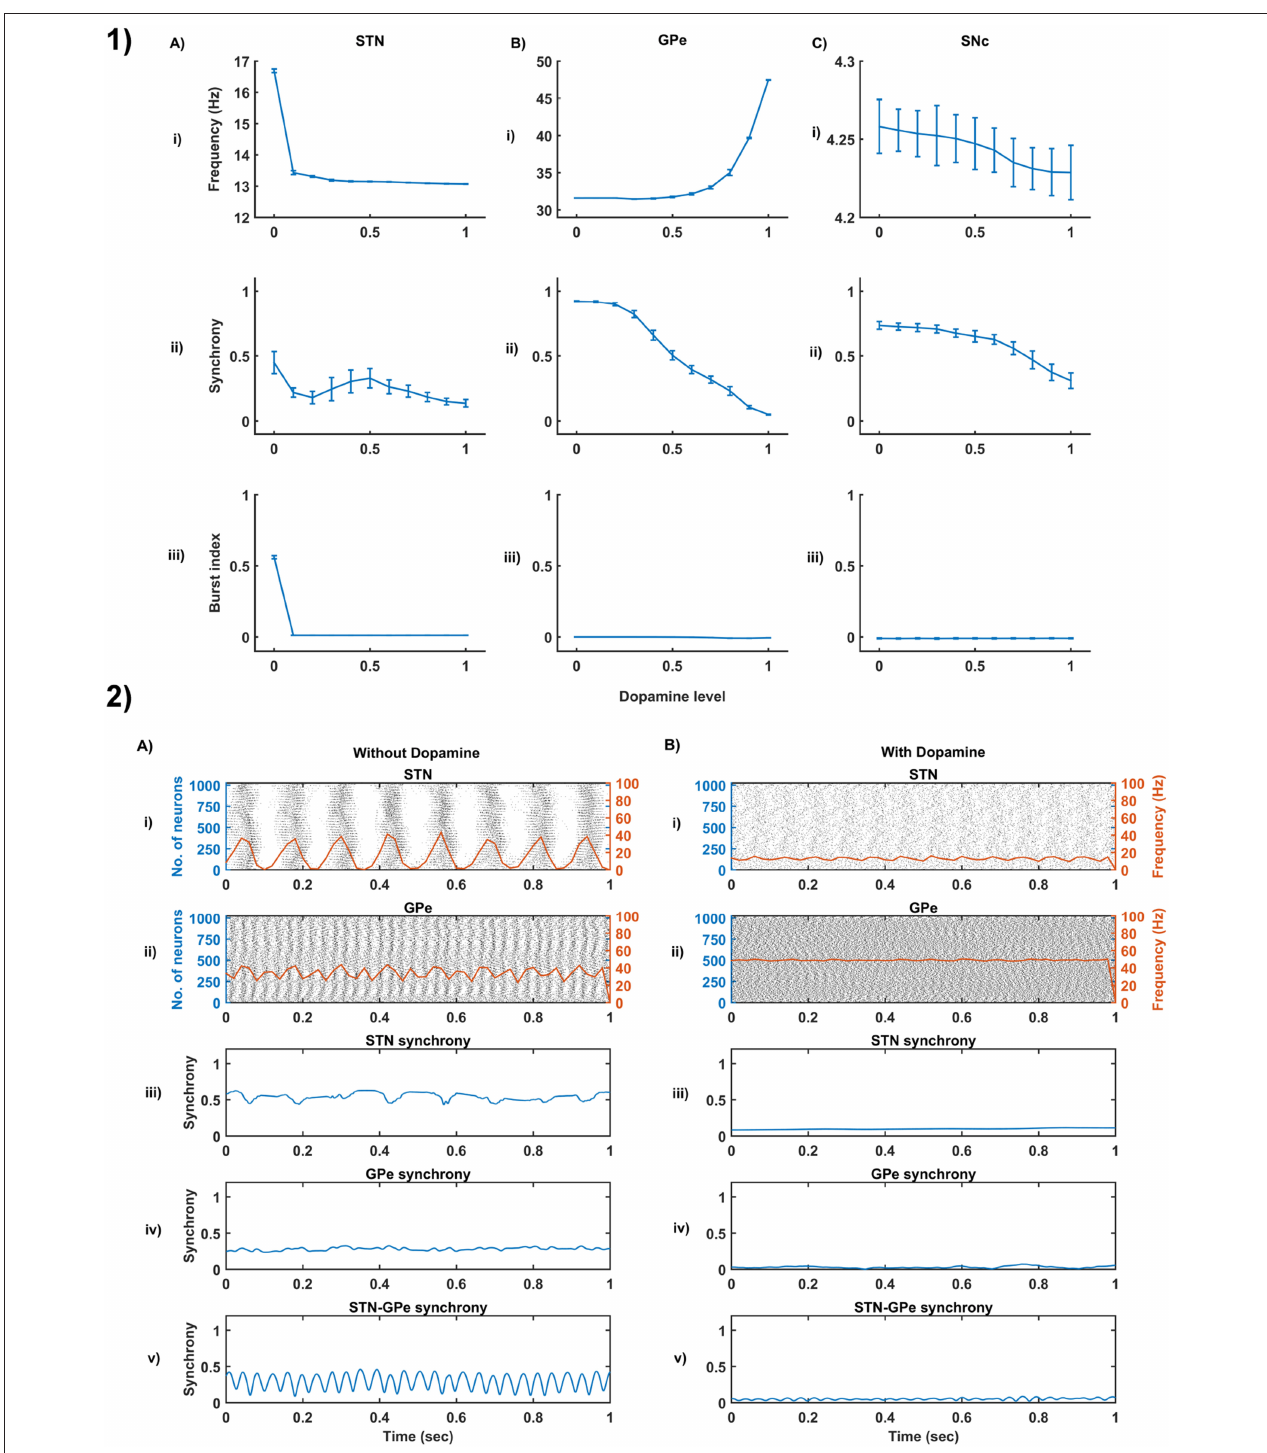
FIGURE 4 | Dopamine effect on the basal activity of different neuronal types. (1) The response of STN (A) , GPe (B) , and SNc (C) populations for varying dopamine levels at the level of network properties [Frequency (i) , Synchrony (ii) , and Burst Index (iii) ]. (2) The response of STN-GPe network without (A) & with (B) dopamine - Raster plots of STN (i) & GPe (ii) populations overlaid with spike-count firing rate (orange line), Synchrony plots of STN (iii) , GPe (iv) , and combined STN-GPe (v) . STN, SubThalamic Nucleus; SNc, Substantia Nigra pars compacta; GPe, Globus Pallidus externa.